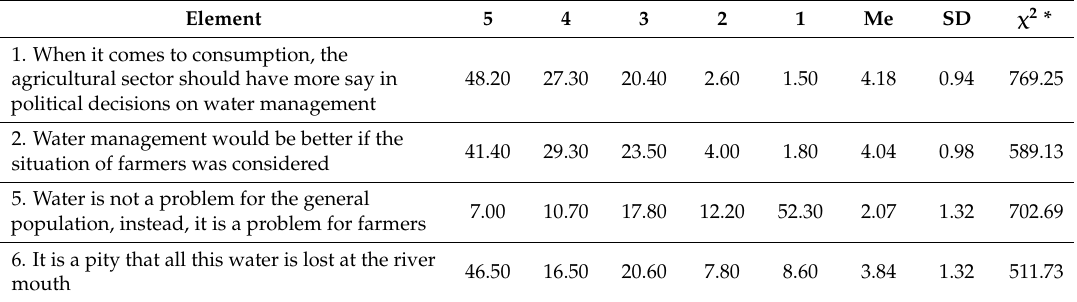
Table 2. Results expressed in terms of a percentage of the respondents of the representative function. Element